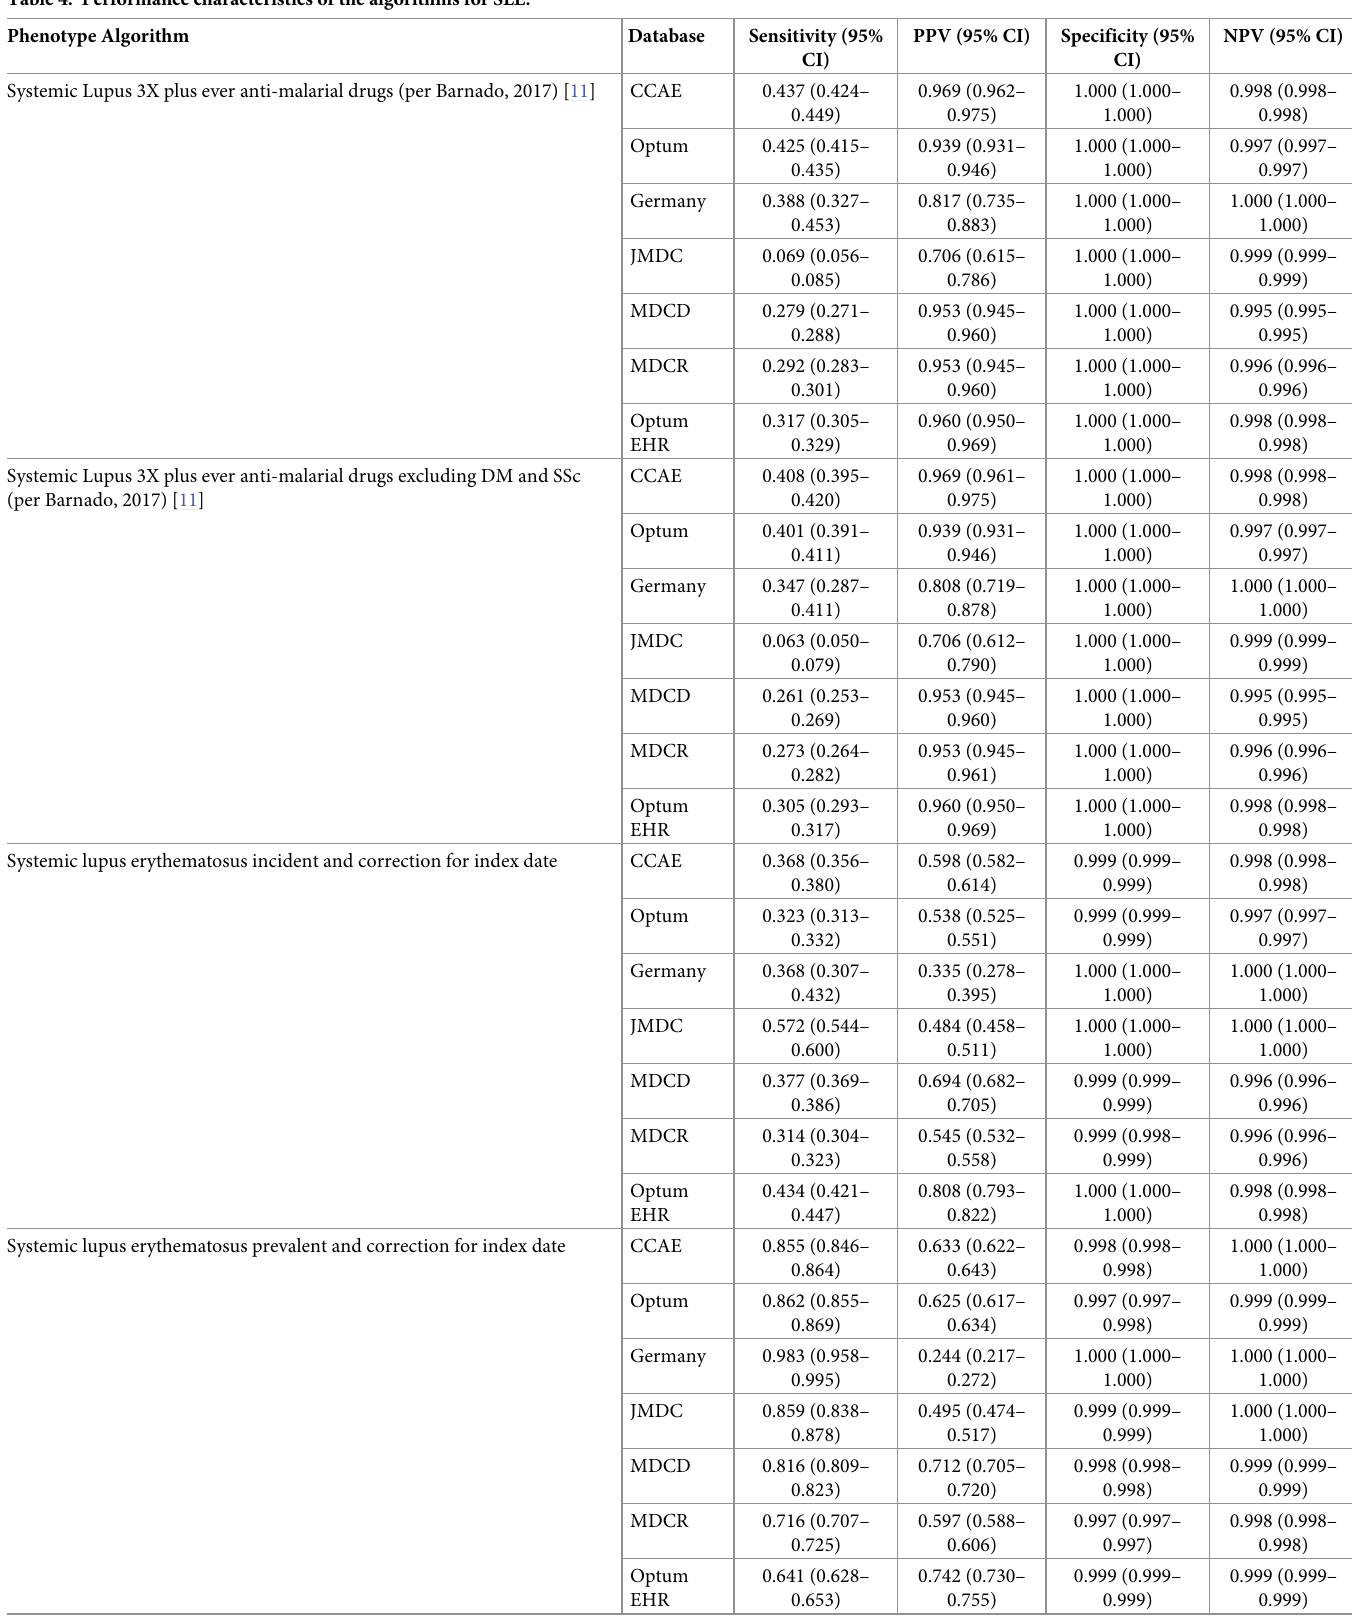
Table 4. Performance characteristics of the algorithms for